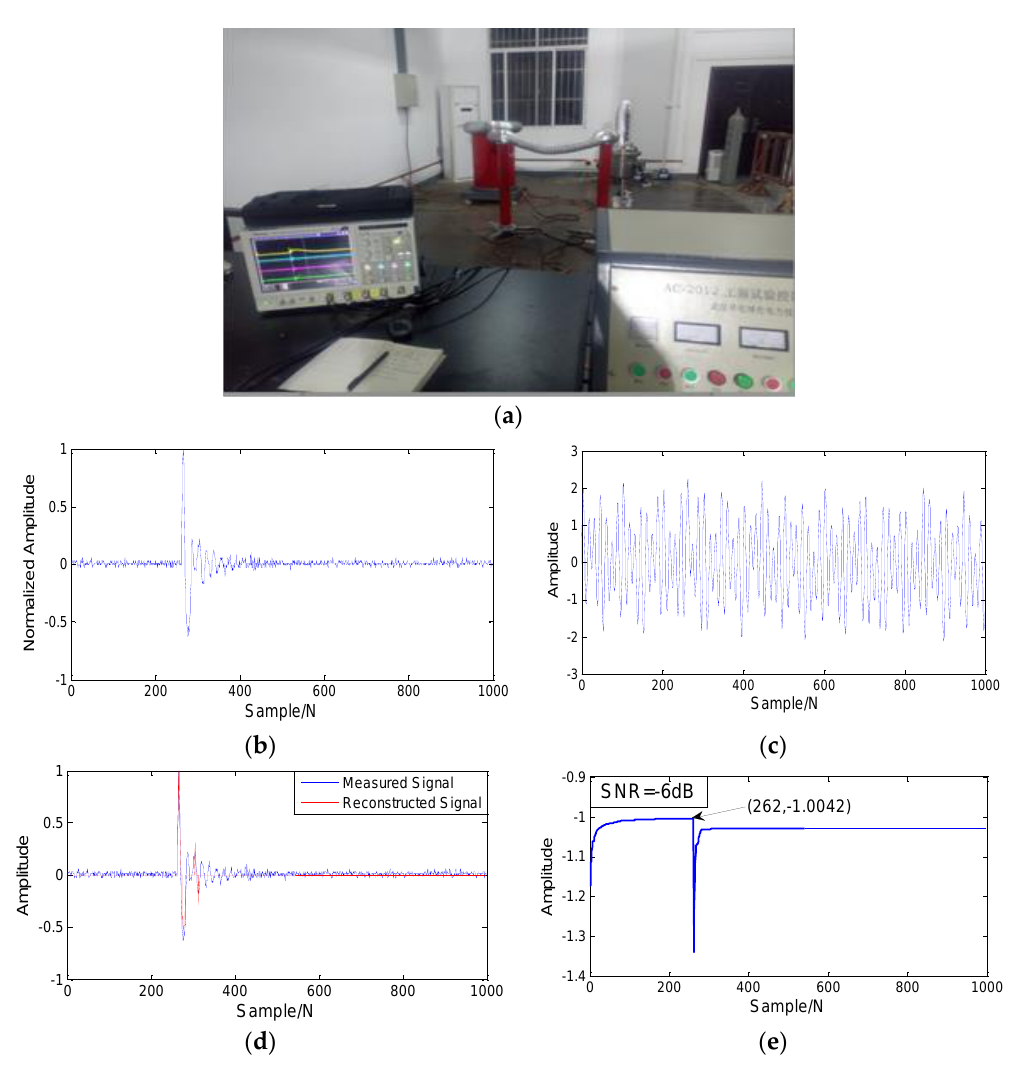
Figure 9. Measured data processing result: ( a ) PD experiment platform; ( b ) Measured PD signal; ( c ) Measured PD signal after artificially adding noise; ( d ) The result of denoising by the algorithm of this paper; and ( e ) Time-varying kurtosis curve of the PD signal shown in Figure 8d.